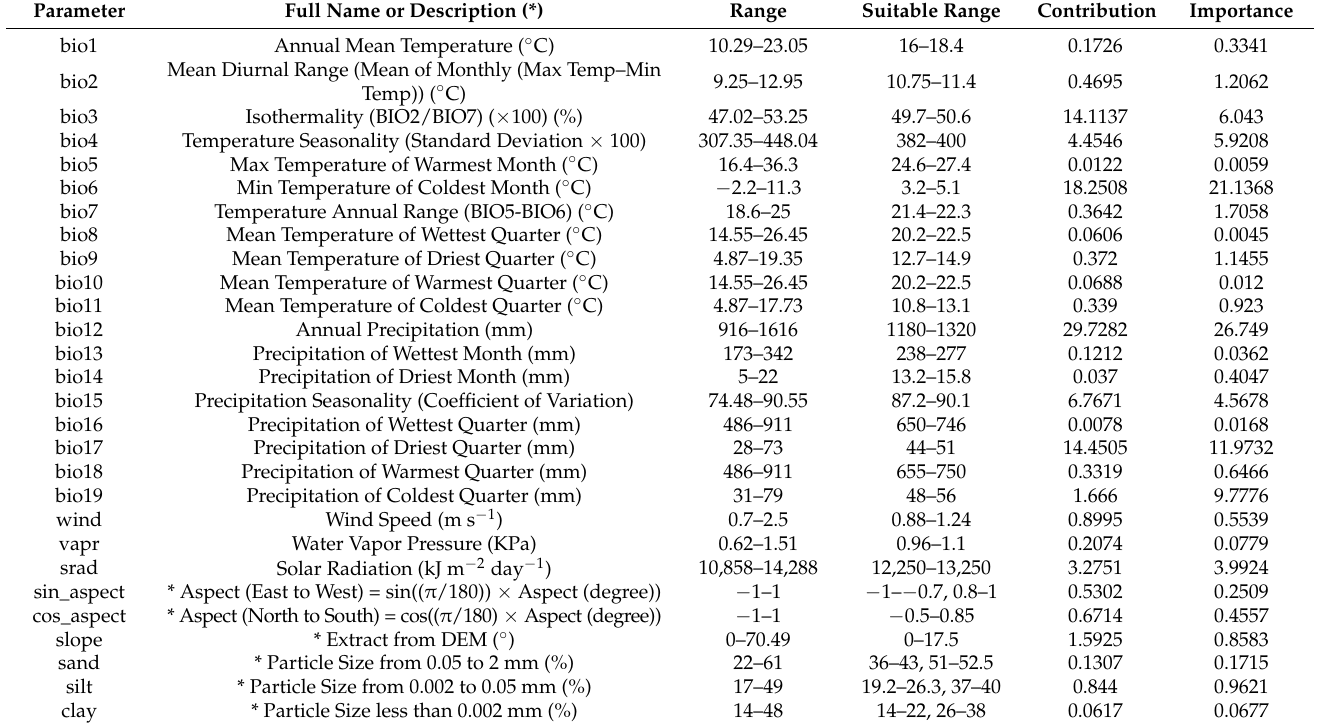
Table 1. Details of the 28 parameters used in the model. Their value ranges, suitable value ranges, percent contribution, and permutation importance are shown. The suitable values were extracted when the logistic output > 0.5 (high values indicate high suitability) [53]. Contribution and importance are percentage